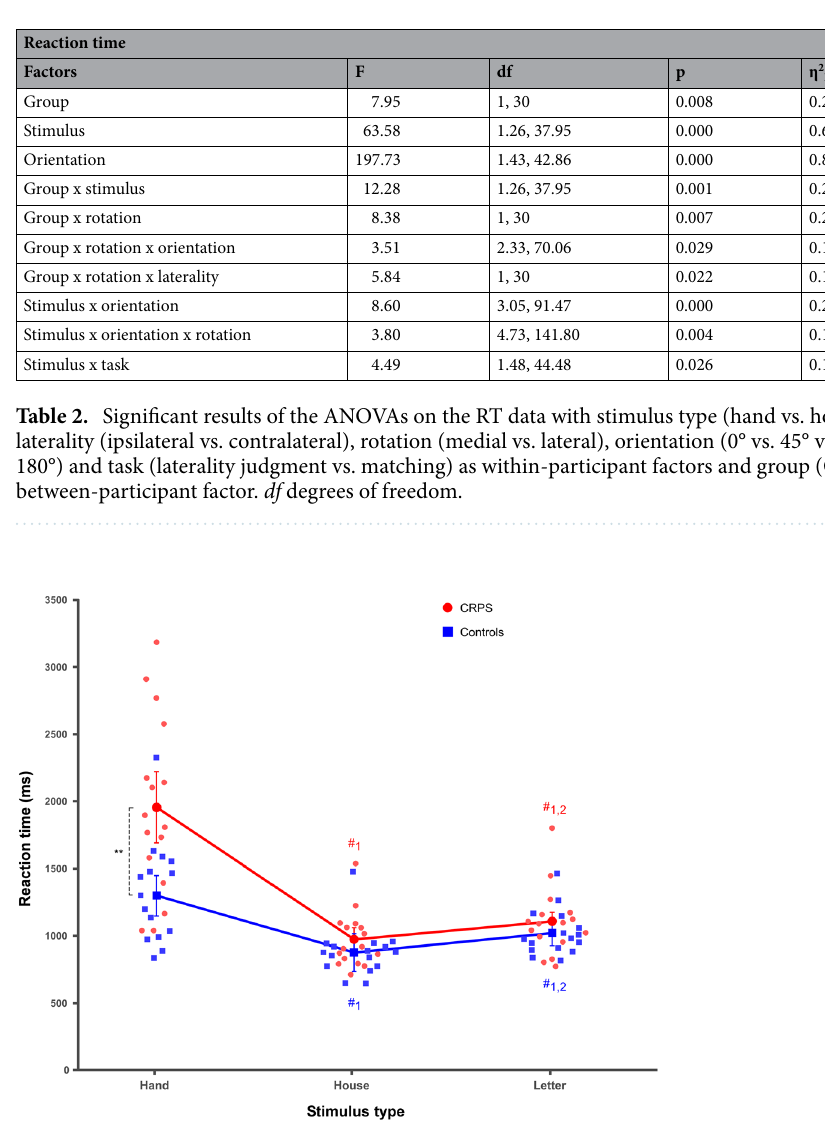
Figure 3. Mean reaction times (RT) according to group and stimulus type. CRPS patients are represented in red circles and control participants in blue squares. Smaller and lighter colored circles/squares represent the individual data. Error bars represent the 95% confidence intervals adapted according to the method of Cousineau 69 . **p ≤ 0.01. #1 = significantly different from hand stimuli, #2 = significantly different from house